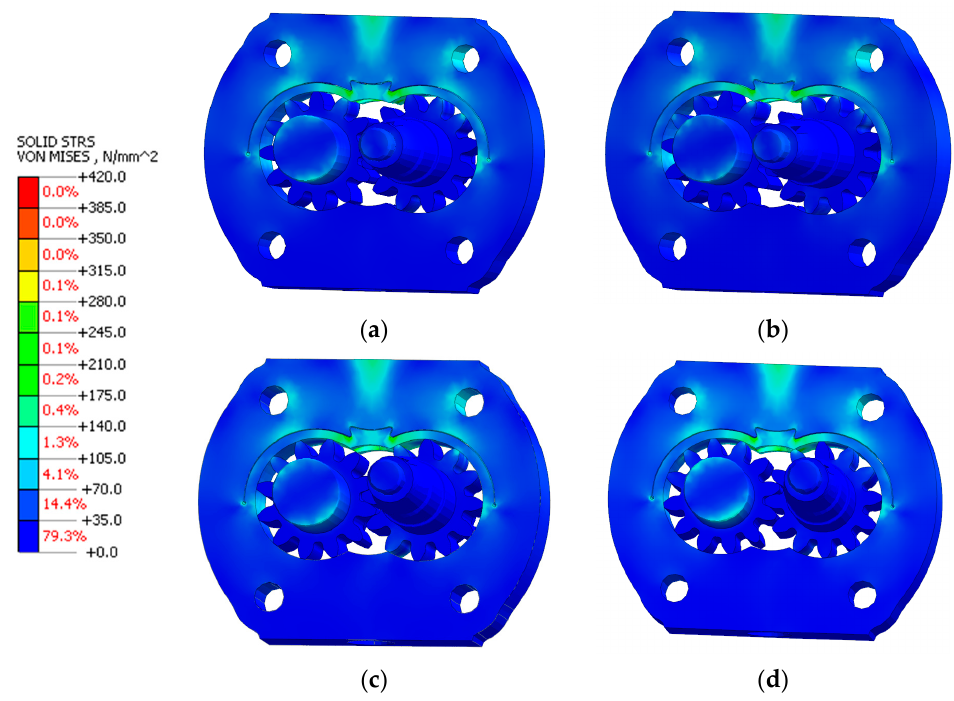
Figure 9. Distribution of stresses reduced acc. to the H-M-H hypothesis in casing A, gear rotation angle: ( a ) 0°, ( b ) 7.5°, ( c ) 15°, ( d ) 22.5°.